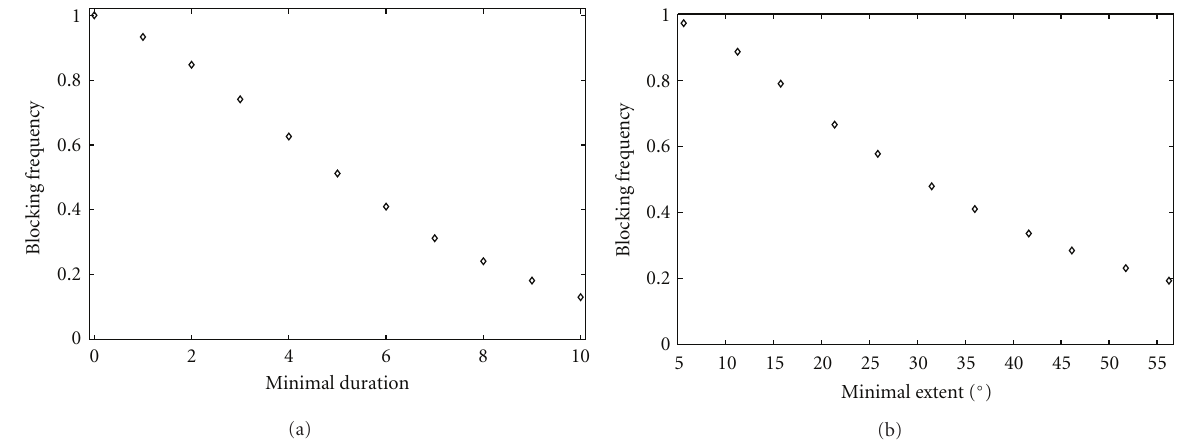
Figure 7: Reduction in zonal mean blocking frequency with increasing (a) persistence filter (without extent or quantile filters) and (b) extent filter (without time or quantile